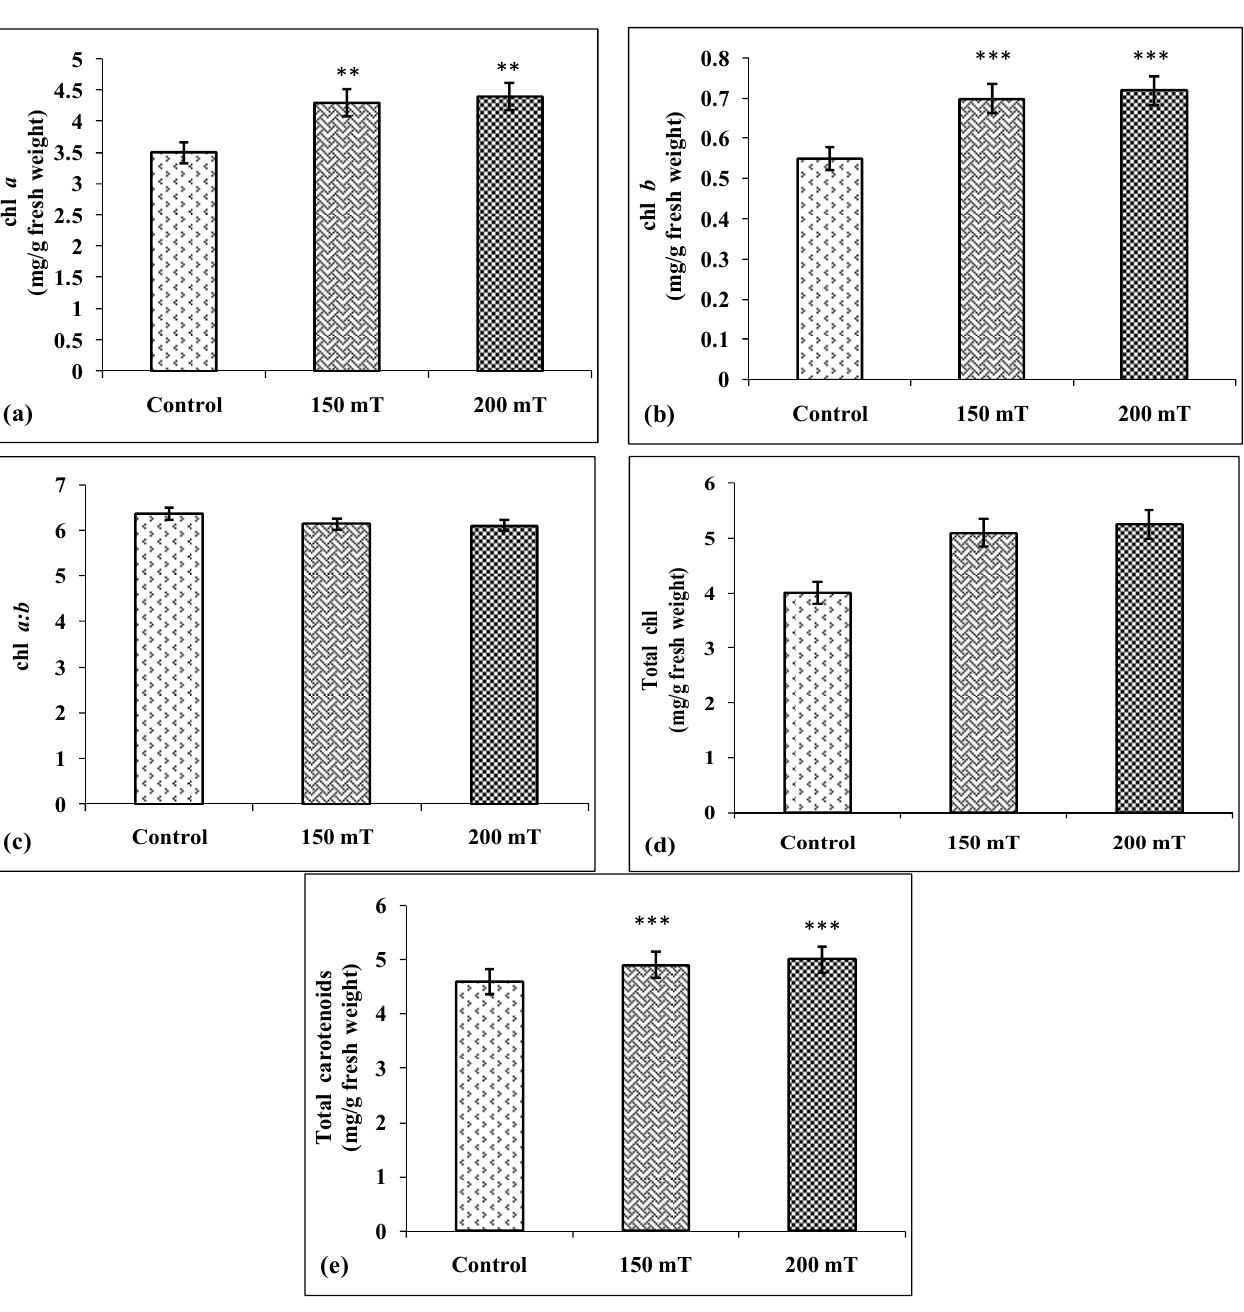
Figure 6. Effect of pre-sowing magnetic field treatment of soybean seeds on chlorophyll a ( a ), chlorophyll b ( b ), chlorophyll a:b ratio ( c ), total chlorophyll ( d ), and carotenoid ( e ) content. *** and ** indicate significance at p < 0.001 and 0.01, respectively, compared to control.